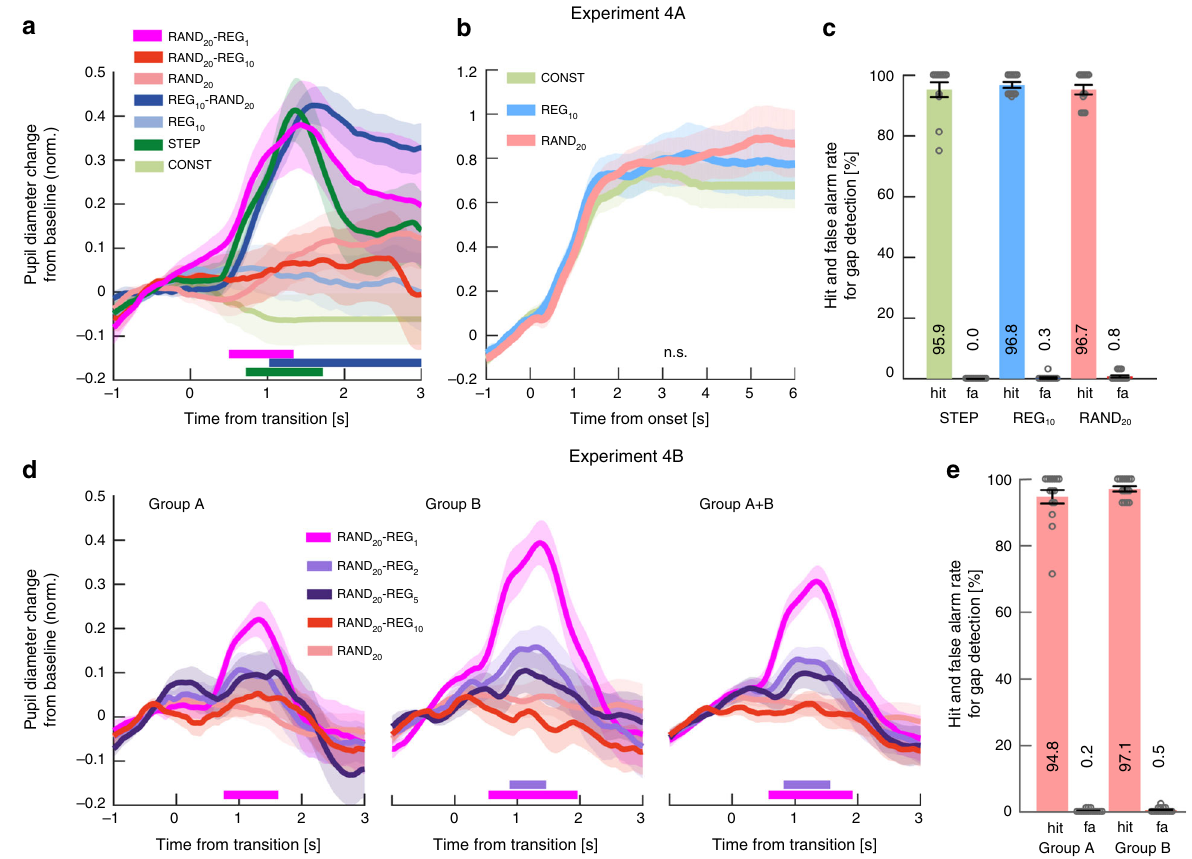
Fig. 10 Abrupt reduction in the PDR for regularities more complex than REG 1 . a Average pupil diameter relative to the transition in Experiment 4A ( n = 12). Solid lines represent the average normalized pupil diameter, relative to the transition. The shaded area shows ± 1 SEM. Colored horizontal lines indicate time intervals where cluster-level statistics showed signi fi cant differences between each change condition and its control. A robust PDR was evoked by the transition in RAND 20 -REG 1 , becoming signi fi cant between 500 and 1340 ms post-transition The data also replicate the general pattern in Experiments 1 and 2: Both STEP and REG 10 -RAND 20 evoked a PDR; the former started from 720 ms lasting through to 1720ms, and the latter from 1020 ms onwards.